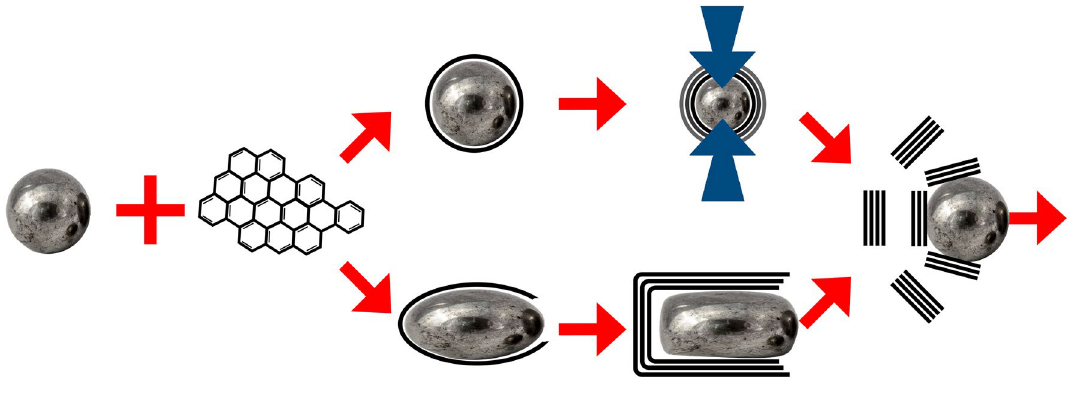
Figure 5. Two possible BCG graphitization